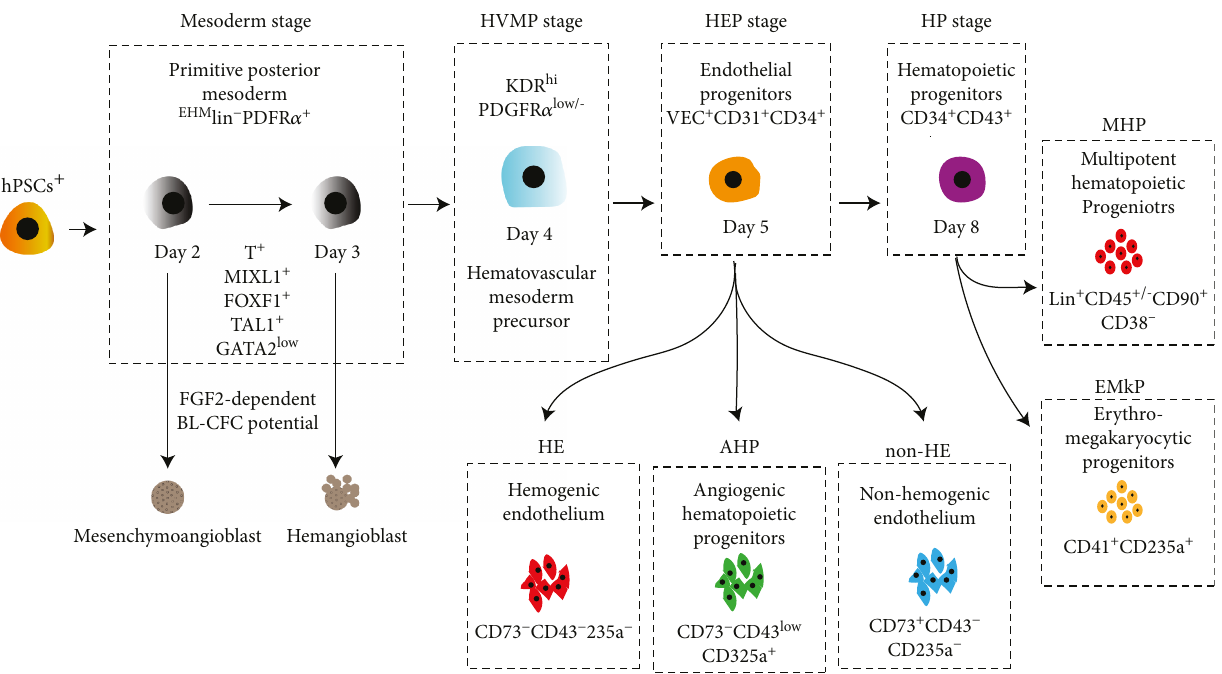
Figure 3: Established stages of hematopoietic development from hPSCs + . The primitive mesodermal precursors are capable of forming mesenchymoangioblast (MB) and hemangioblast (HB) in the presence of FGF2 [62, 122, 125]. Mesodermal commitment to angiohematopoietic development progressively leads to the formation of EMH lin − KDR bright APLNR + PDGFRa low/ − hematovascular mesodermal precursors (HVMPs) [62, 89]. The HEP stage was identi fi ed based on the expression of the typical endothelial markers VE- cadherin, CD31, and CD34 and the absence of the panhematopoietic marker CD43 [62, 88]. HE cells were distinguished from non-HE cells based on the presence of CD73 expression [62, 132]. Initial hematopoietic progenitors arising from the VE-cadherin+ population show the presence of CD235a, low levels of CD43, and absence of CD41a expression. These cells can form hematopoietic colonies in the presence of FGF2 and retain their endothelial potential. These progenitors were labelled as angiogenic hematopoietic progenitors (AHPs) [62, 132]. Progressive hematopoietic development is identi fi ed by the appearance of CD43 expression, and all hematopoietic CFCs are accumulated in this fraction. Distinct subsets of CD43 + hematopoietic cells, including CD41a + CD235a + erythromegakaryocytic progenitors and lin − CD34 + CD43 + CD45 +/ − multipotent myelolymphoid progenitors, are also established [63, 88, 89,